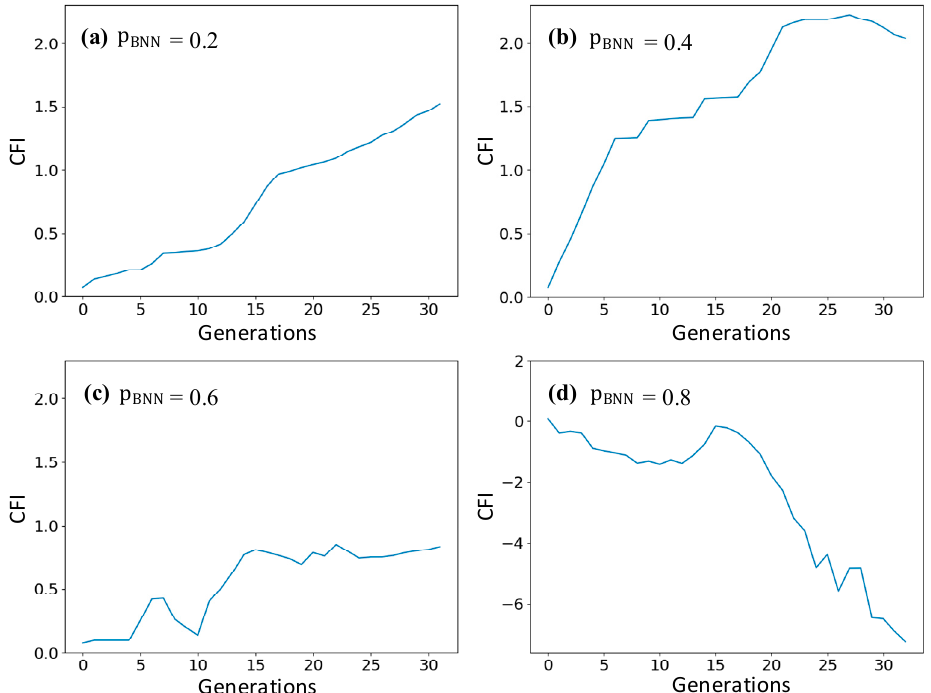
Figure 9. The cumulative fitness improvement in different SGA runs when p BNN equals ( a ) 0.2, ( b ) 0.4, ( c ) 0.6, and ( d ) 0.8.